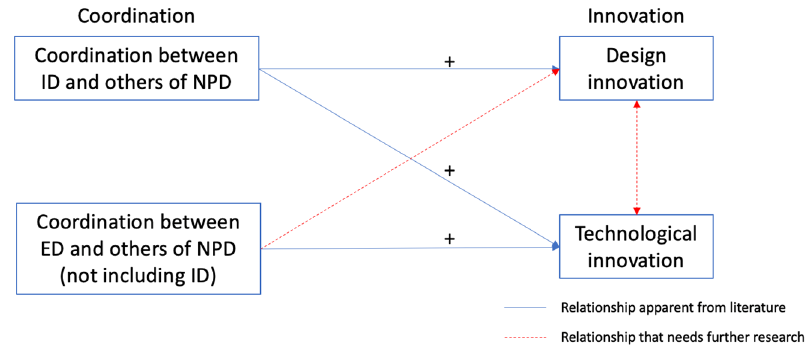
Figure 2. Relationship between coordination and